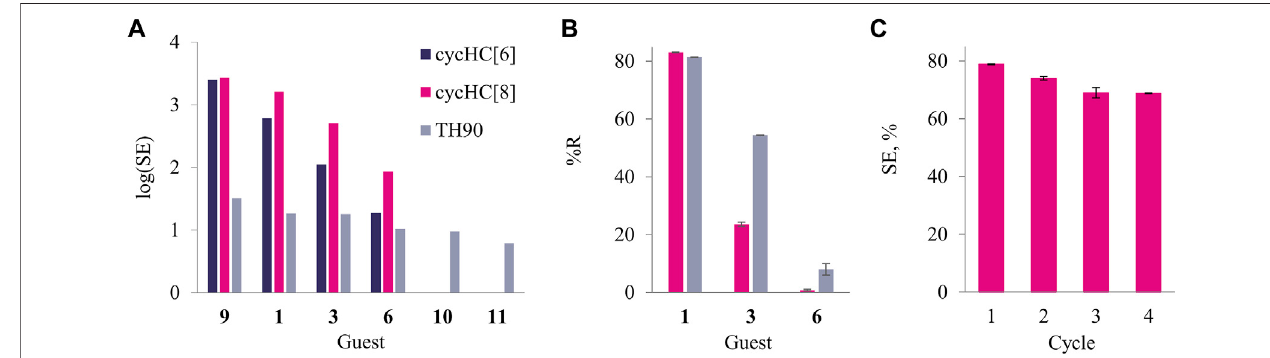
FIGURE4|(A) SEofcycHC[6], cycHC[8], and TH90 (dark blue, pink, and gray, respectively) inwater, displayed inlogarithmicscale; (B) selectivity ofSPE from the mixture of 1, 3 , and 6 by cycHC[8] and TH90, at comparable sorbent amount granting %R ca 80% for 1 ; (C) %R exhibited by cycHC[8] throughout repeated extraction cycles of 1 [Error bars stand for the standard deviation between parallel experiments (n ≥ 2). For more details, see Supplementary Material S38 – S50 , S57 ].